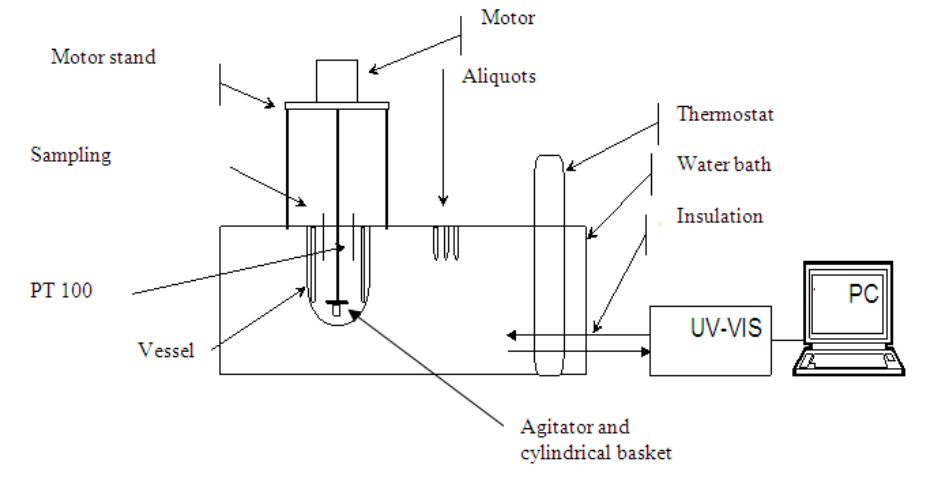
Figure 3. Dissolution experiment assembly.